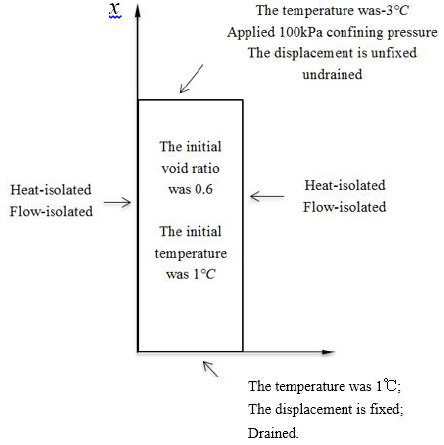
Figure 8. The boundary and initial conditions.